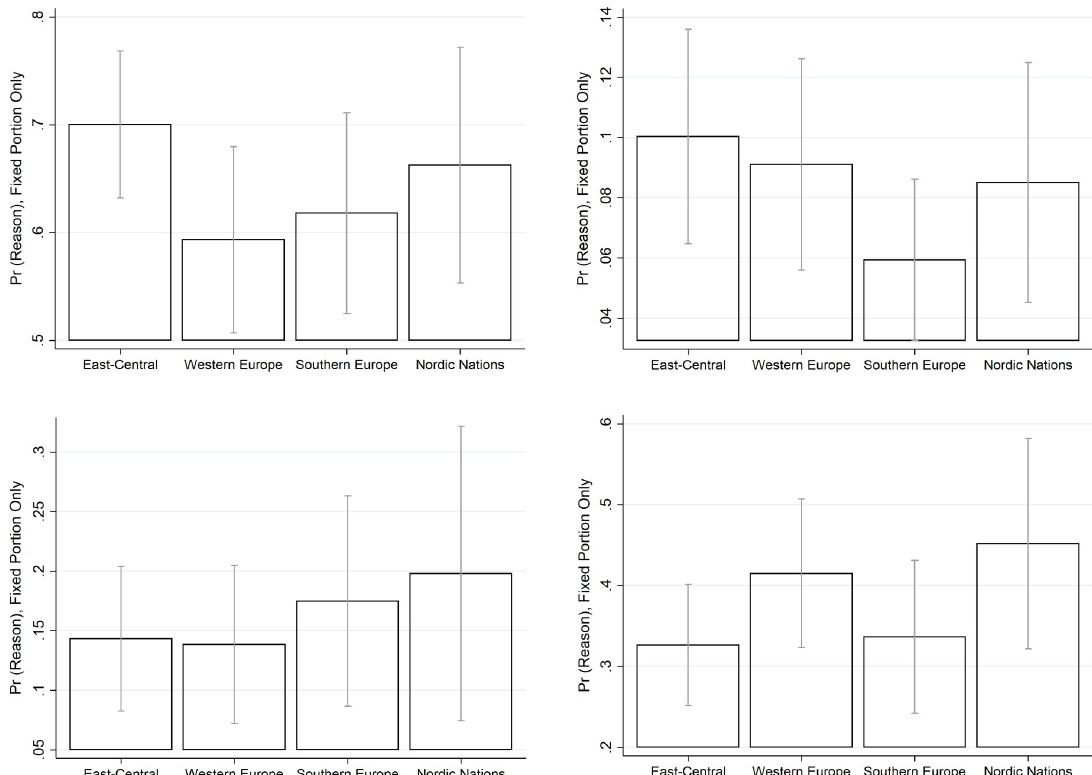
Fig 2. Predicted probabilities of reasons for a ‘representative consumer’ to make purchases from the informal economy: By region (with 95% CI). A. More convenient 1) B. Lack of availability on regular market, C. Involuntary, D. Social and/or redistributive reasons. Notes : 1) Lower price and/or faster/better service/product. Source : author‘s calculations based on data from Special Eurobarometer 498 – Wave EB92.1, Undeclared Work in the European Union, Fieldwork—September 2019 / Publication date—February 2020 (European Commission,